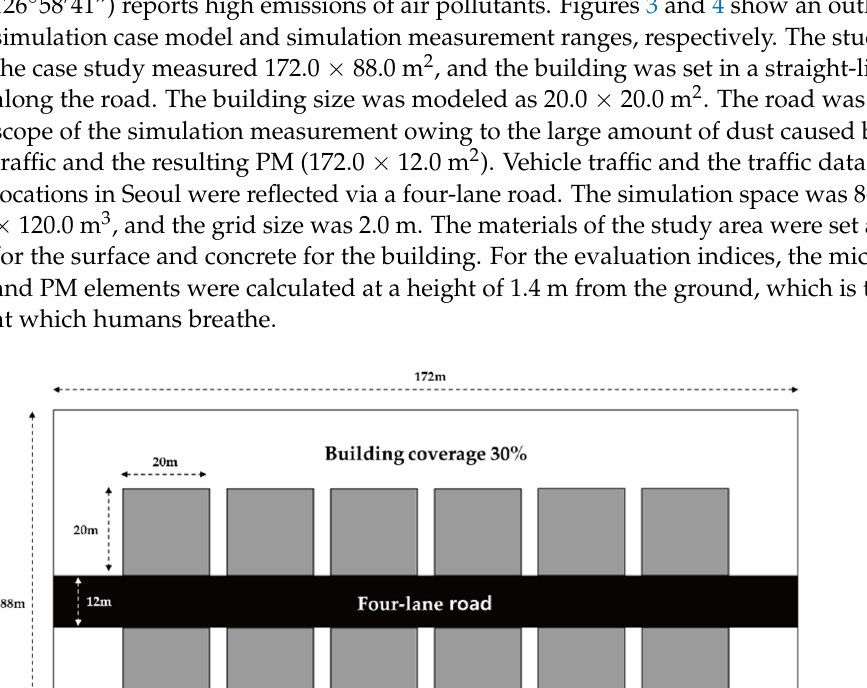
Figure 2. Case study floor area ratio setting.